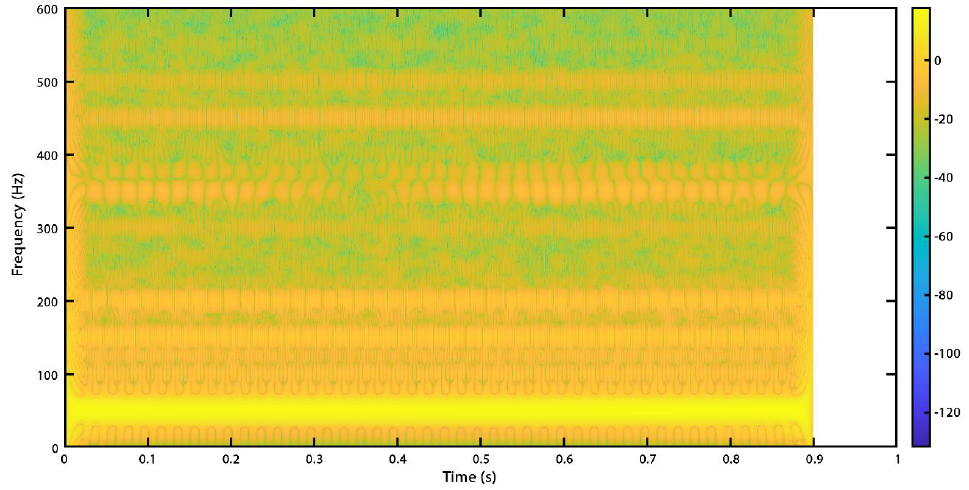
Figure 6. Smoothed PWVD.